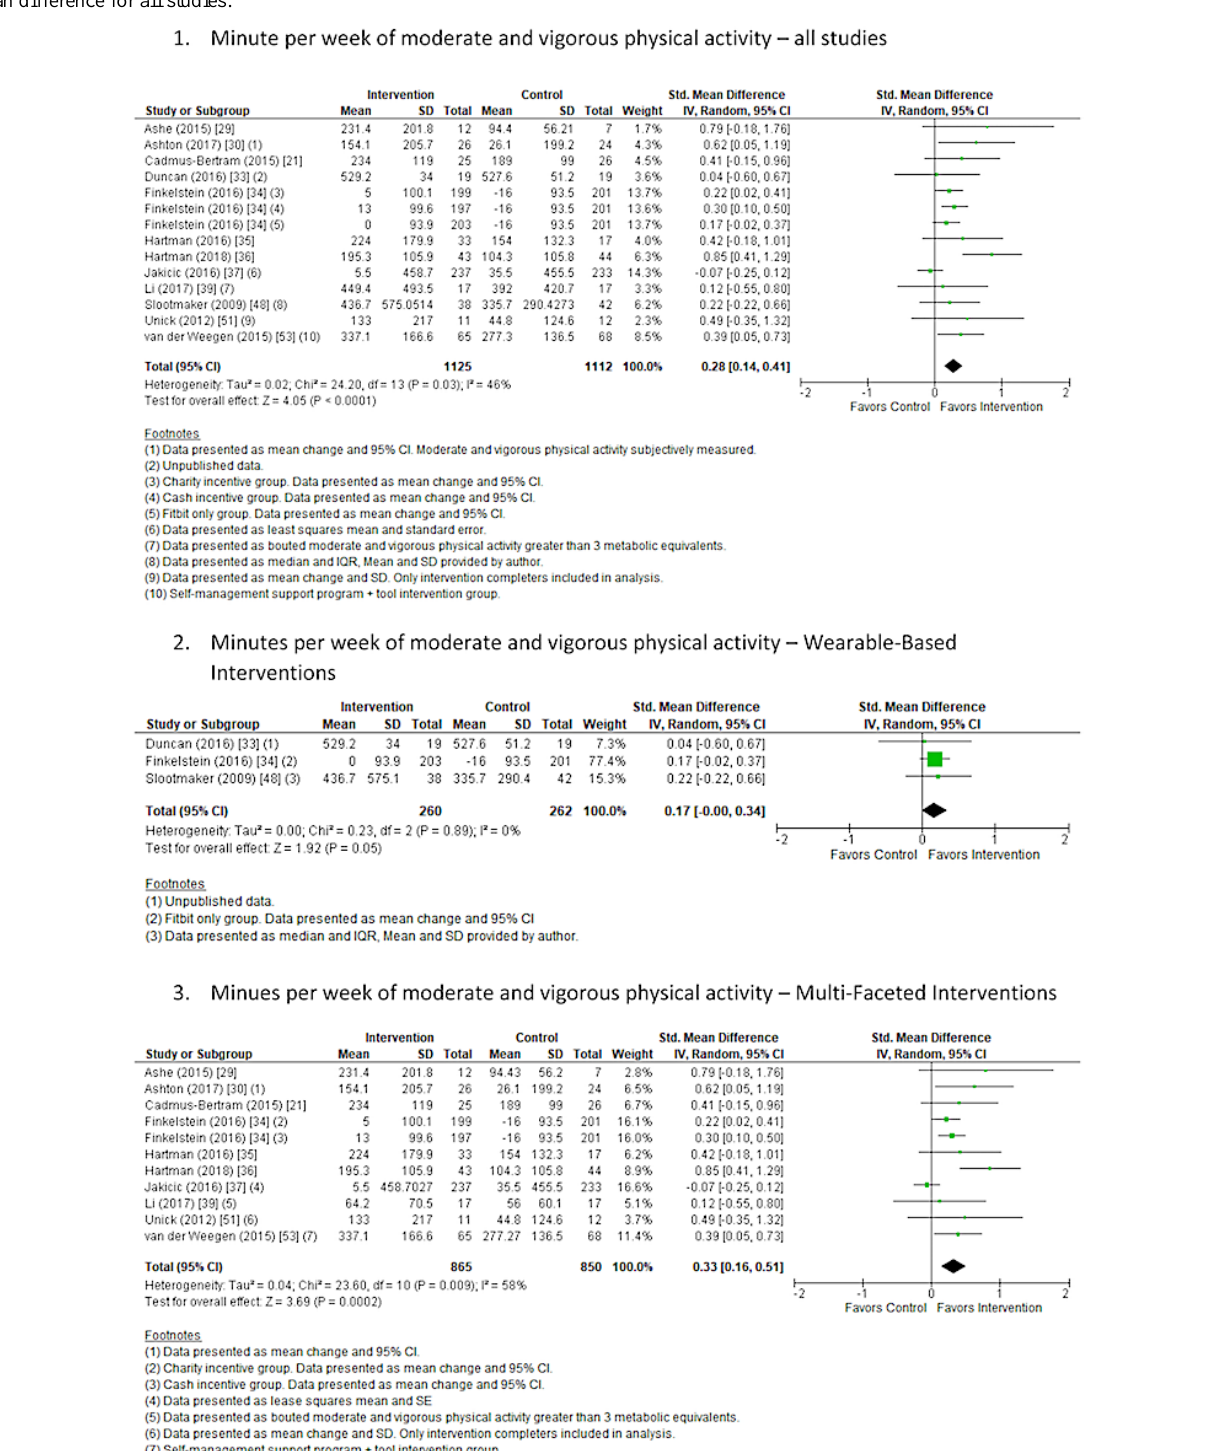
Figure 4. Forest plot of standardized mean difference of time spent in moderate and vigorous physical activity per week in studies comparing an intervention that included a consumer-based wearable activity tracker with a control group that did not utilize a consumer-based wearable activity tracker. Subgroup analysis was completed on studies that included wearable-based interventions compared with control and multifaceted interventions compared with control. Green square indicates the standardized mean difference for each individual study. Black square indicates the overall standardized mean difference for all